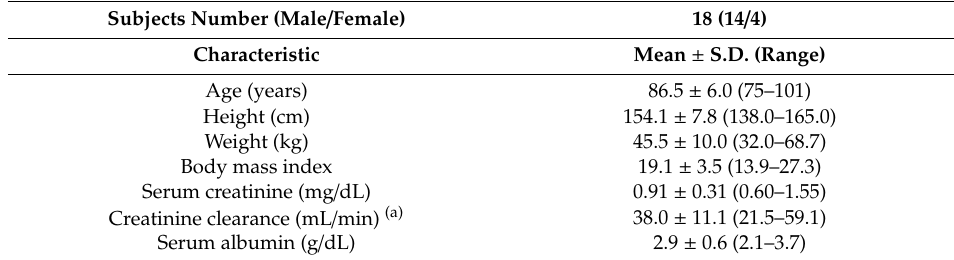
Table 1. Demographic patient